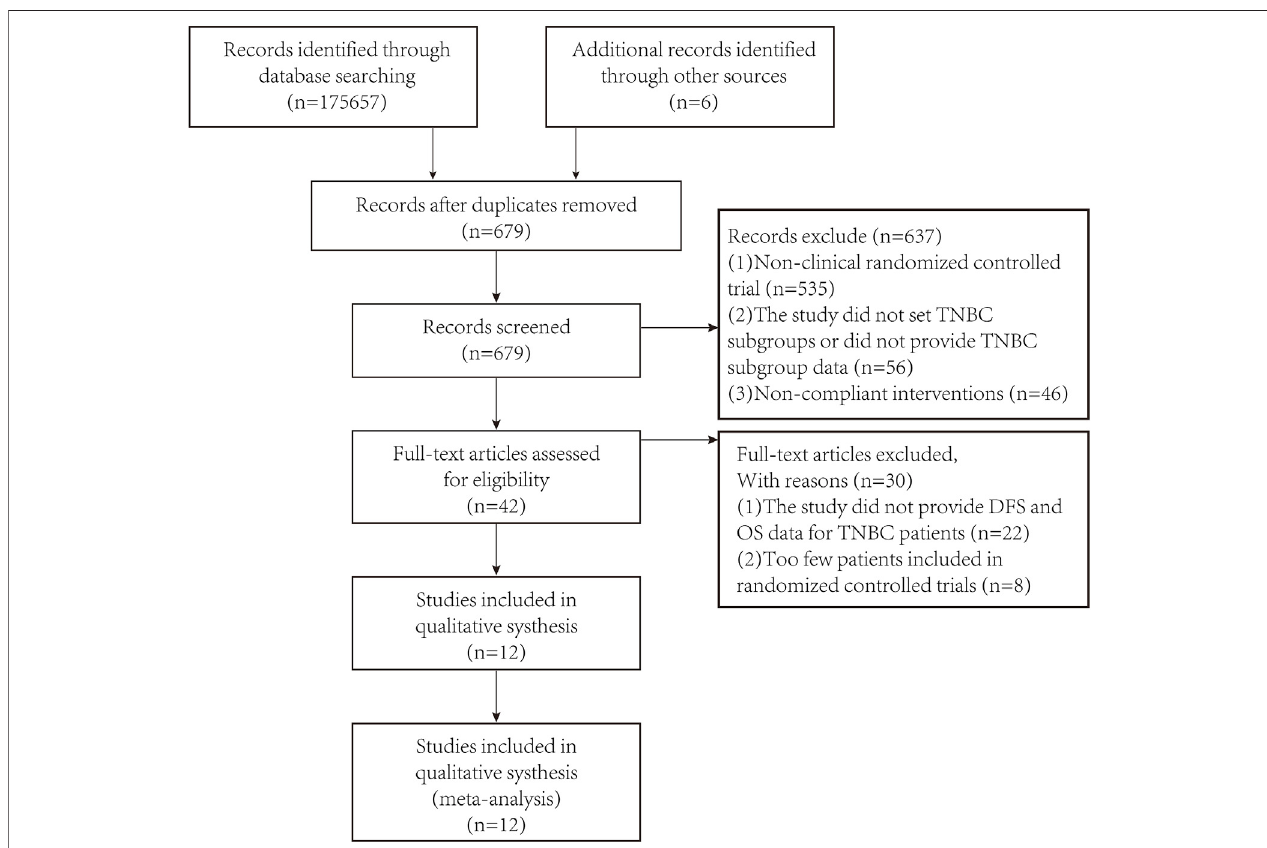
FIGURE 1 | Flow diagram summarizing all study assessment